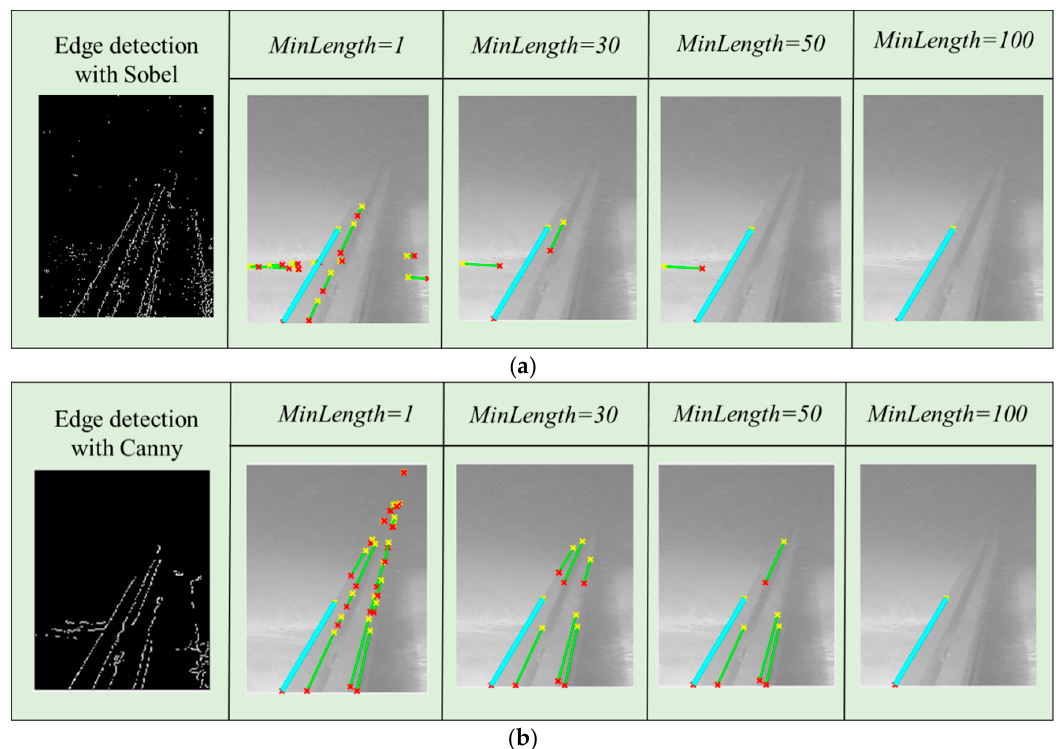
Figure 18. ( a ) Canny edge detector; and ( b ) Sobel edge detector in the underwater environment with different MinLength values.